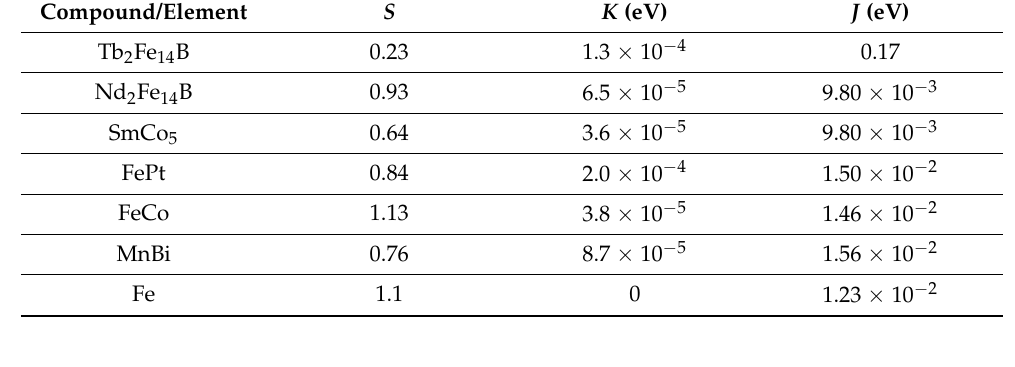
Table 2. Magnetic parameters for the selected compounds used in the simulations. Compound/Element